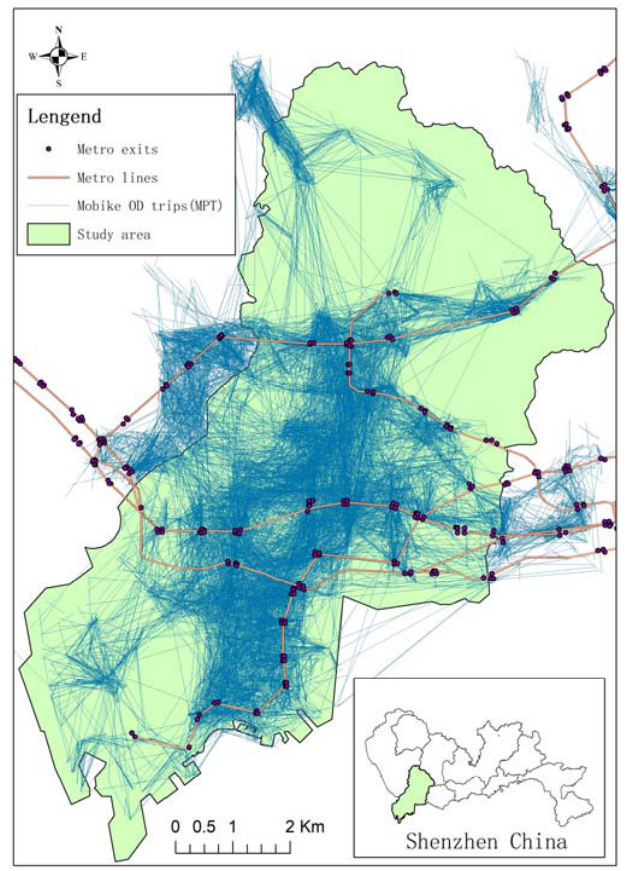
Figure 8. Study area and Mobike OD trips at MPT.